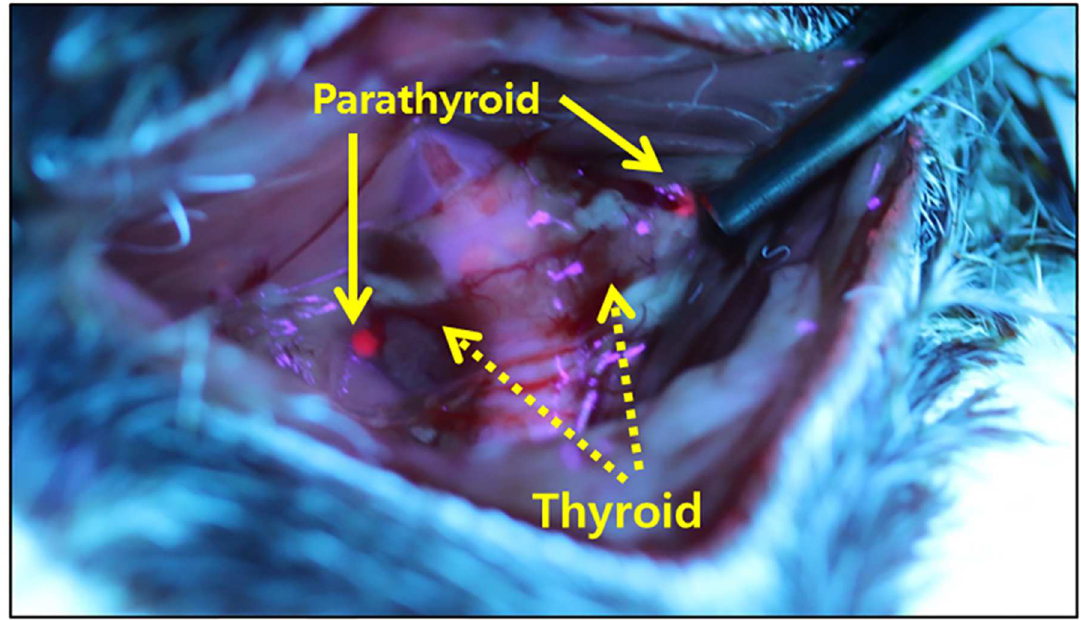
Fig 2. Identification of rat parathyroid glands. The parathyroidglands are clearly identifiable under xenon light as fluorescent red spots next to the thyroid glands.